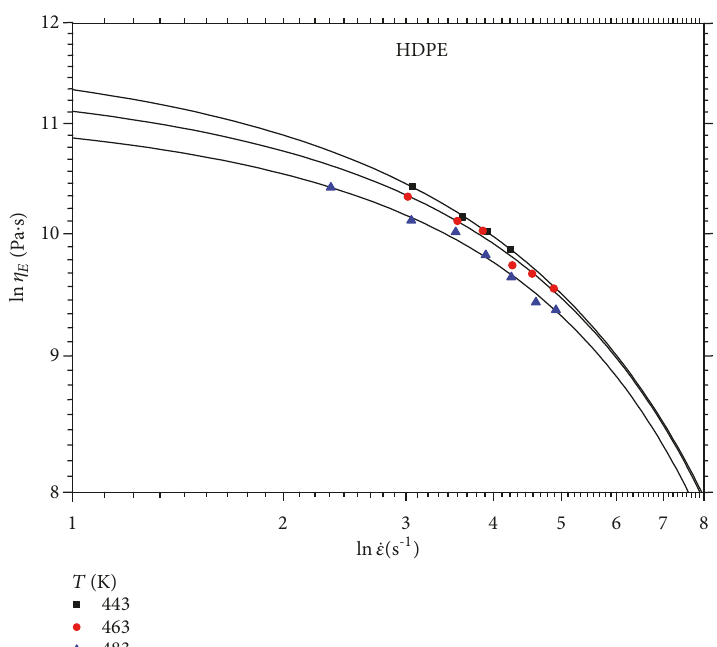
Figure 1: Logarithm of viscosity versus logarithm of elongational rateof HDPE at atmospheric pressure and various temperatures.Solid lines represent data fitting through each data set [4] by